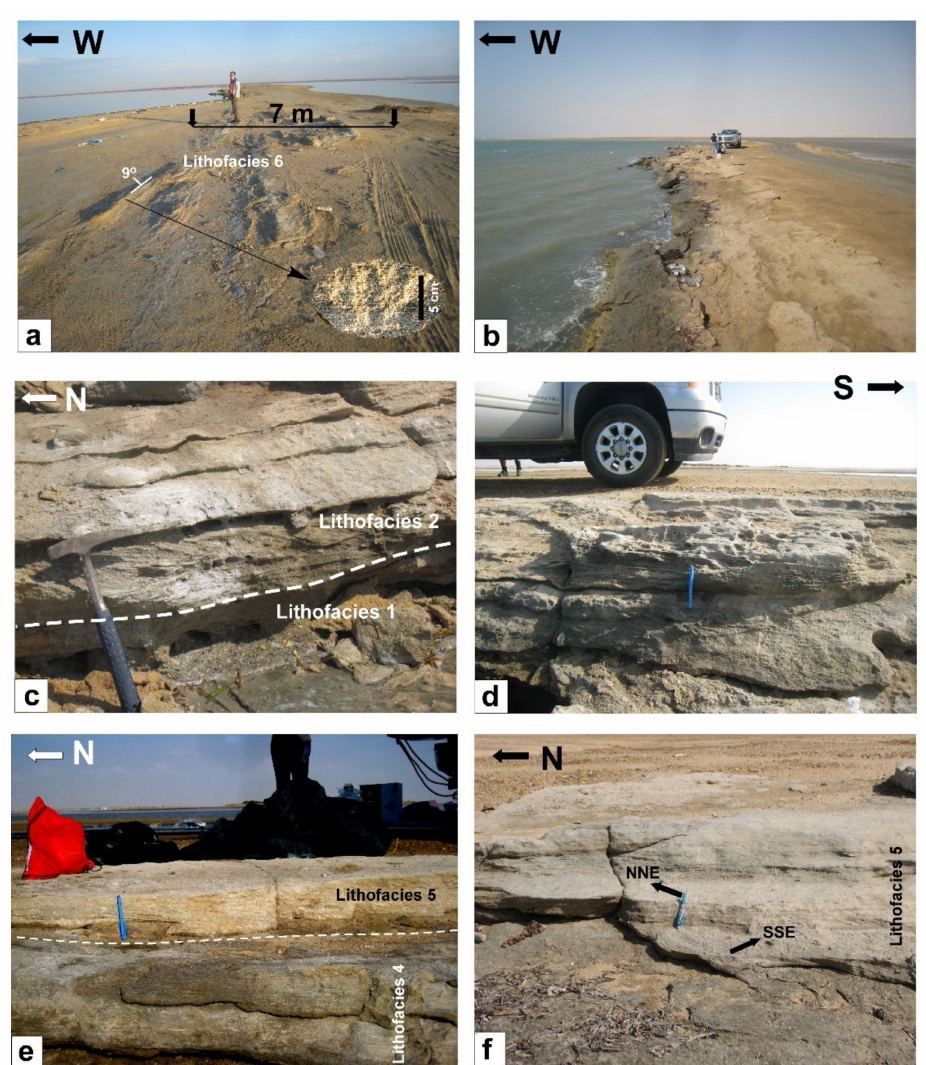
Figure 3. Field photographs showing the characteristic features of the beachrock of the Al-Mejarma: ( a ) An overview of strike and inland extension of Al-Mejarma beachrock. This part shows the seaward inclined foreshore sandstones (lithofacies 6); ( b ) General overview showing breakdown and sliding of beachrocks due to modern wave erosion. The person is 1.7 m tall; ( c ) Coarse-grained pebbly sandstones of lithofacies 1 overlain by wave ripple cross-laminated sandstones of lithofacies 2; ( d ) Low-angle cross-lamination of lithofacies 3; ( e ) Ripple cross-laminated (lithofacies 4) showing foresets draped by mica and foresets dipping toward N and NNE, and low-angle planar cross- laminated medium-grained sandstones of lithofacies 5 with foresets trending SSE, and ( f ) Low-angle tabular cross-laminated medium-grained sandstones of lithofacies 5. Note the current directions towards SSE and NNE. The scale is hammer = 0.33 m, pen in ( d – f ) =